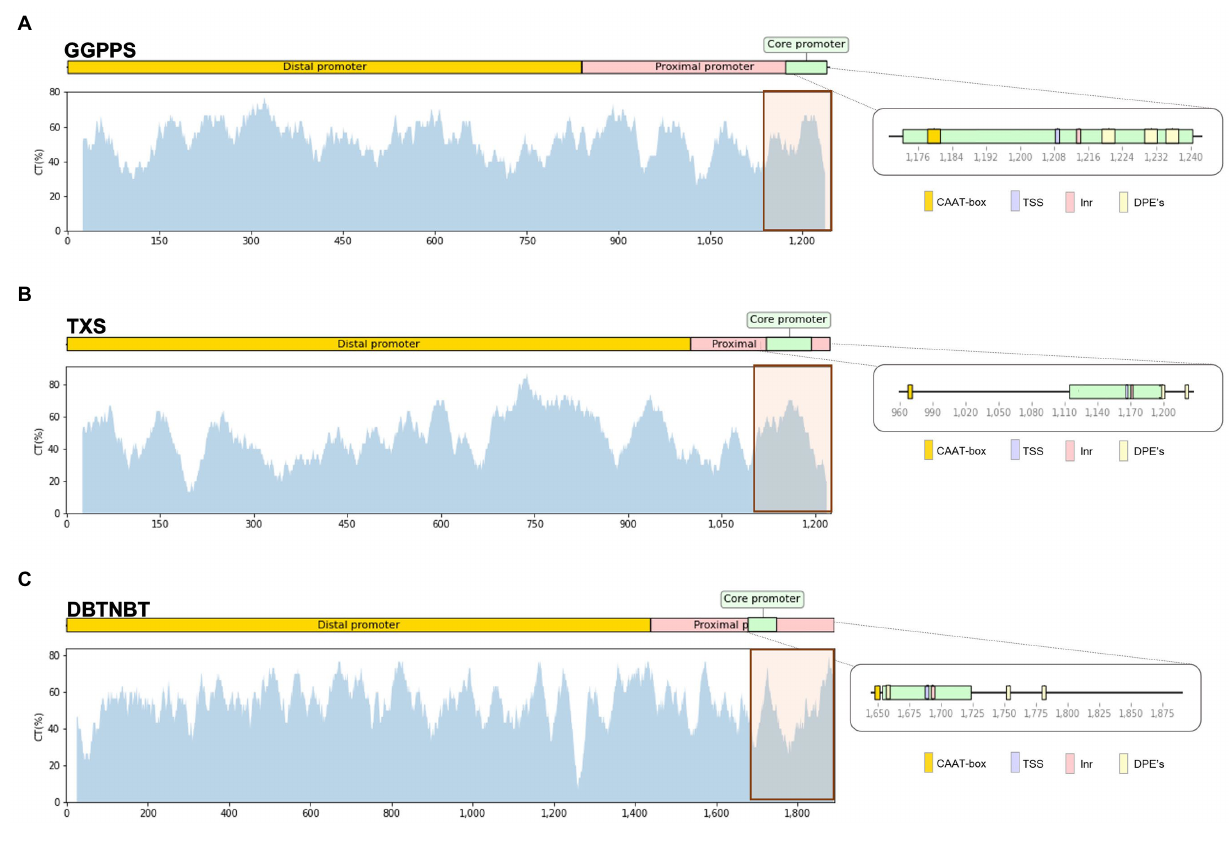
FIGURE 2 | Percentage of pyrimidine presence in the promoter. It is represented the distal, proximal, and core promoter. The predicted cis elements are detailed in the zoomed core promoter. (A) GGPPS promoter, (B) TXS promoter and (C) DBTNBT